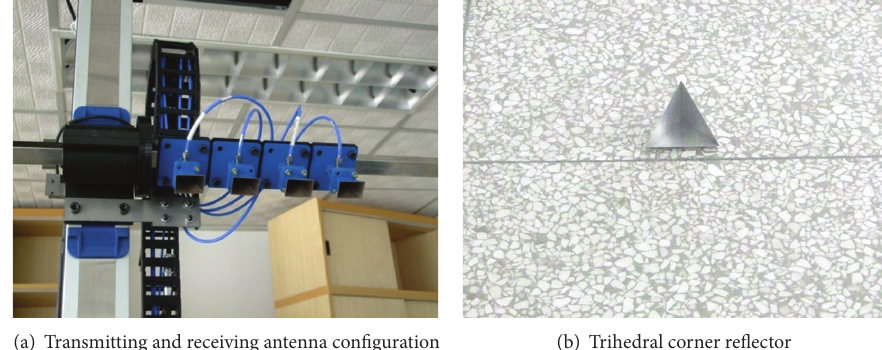
Figure 11: Antenna configuration and trihedral corner reflector in ground-based DPCA SAR system.